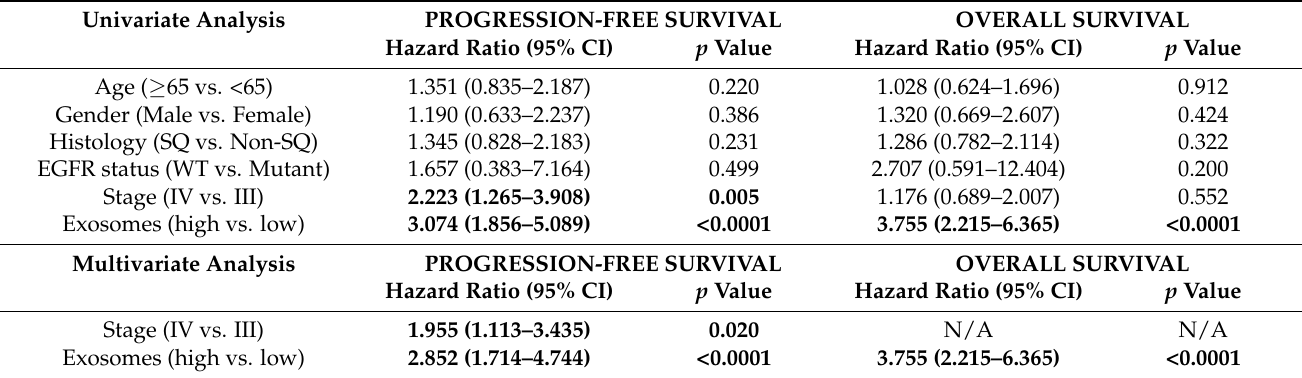
Table 2. Univariate and multivariate analysis of PFS and median OS for untreated NSCLC patients. Univariate